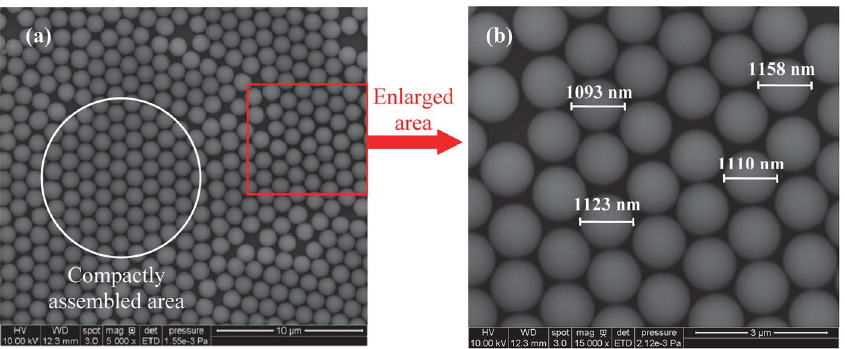
Figure 1. SEM images of 2-D monolayer array of silica particles assembled on a silicon wafer. The average diameter of the particles is about 1120 nm.